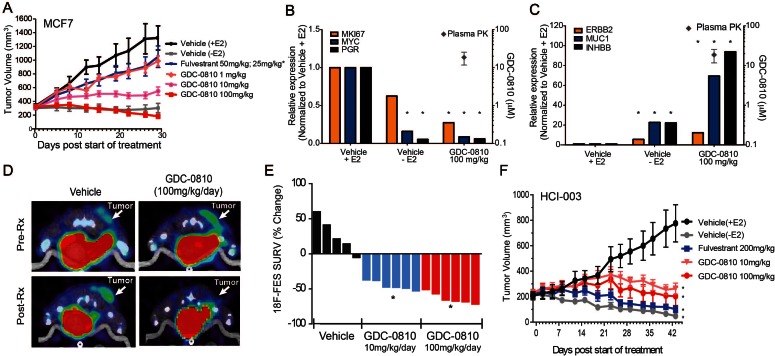
Antitumor activity and pharmacodynamic response of GDC-0810 in tamoxifen-sensitive breast cancer xenograft models.(A) Tamoxifen-sensitive MCF7 tumor bearing animals were dosed with vehicle, fulvestrant (50 mg/kg on days 1, 3, 8; then 25 mg/kg 2x/week, s.c.) or GDC-0810 (1, 10, 100 mg/kg/day, p.o.) for 28 days in the presence of 60-day release 0.36 mg 17β-estradiol pellets. (B, C) Gene expression analysis of tumors treated with 100 mg/kg GDC-0810, compared to tumors in the presence or absence of estrogen pellets. Tumors were harvested on day 28 of the study; this was a separate study from that shown in (A). GDC-0810 plasma concentration is also shown. *p<0.05, n = 3. See Figure 4—figure supplement 1B for an extended panel of genes. (D) Representative FES-PET images of MCF7 tumors in the right dorsum (arrow) of mice treated with vehicle or GDC-0810 (100 mg/kg). Images were taken 1–2 hr after the dosing on the seventh day of treatment. (E) Percent change in FES SUVR after 6 days of treatment. Each bar represents the mean percent change in 18F-labeled estradiol SUVR. Vehicle-treated mice exhibited an average increase of SUVR of 26.1% whereas mice treated with 10 mg/kg and 100 mg/kg exhibited a 45.2% and 63.3% reduction in SUVR, respectively, compared to baseline (*p<0.0001 vs. vehicle). (F) HCI-003 patient derived xenograft tumors were implanted in mice containing a 1 mg 17β-estradiol beeswax pellet. Tumor bearing animals were dosed with vehicle, fulvestrant (200 mg/kg, 3x/week, s.c.), GDC-0810 (10 or 100 mg/kg/day, p.o.) for 43 days. One vehicle treated group had the 17β-estradiol pellets removed at treatment start to assure growth dependence on estradiol.